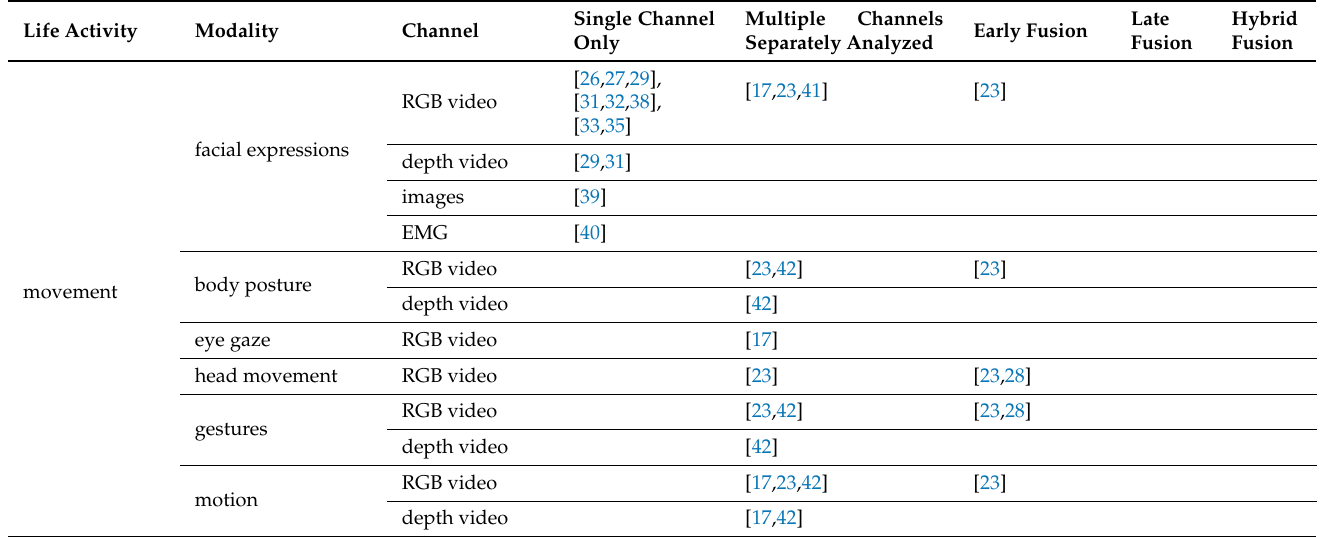
Table 12. Life activities, modalities, and channels analyzed versus unimodal or multimodal ap-